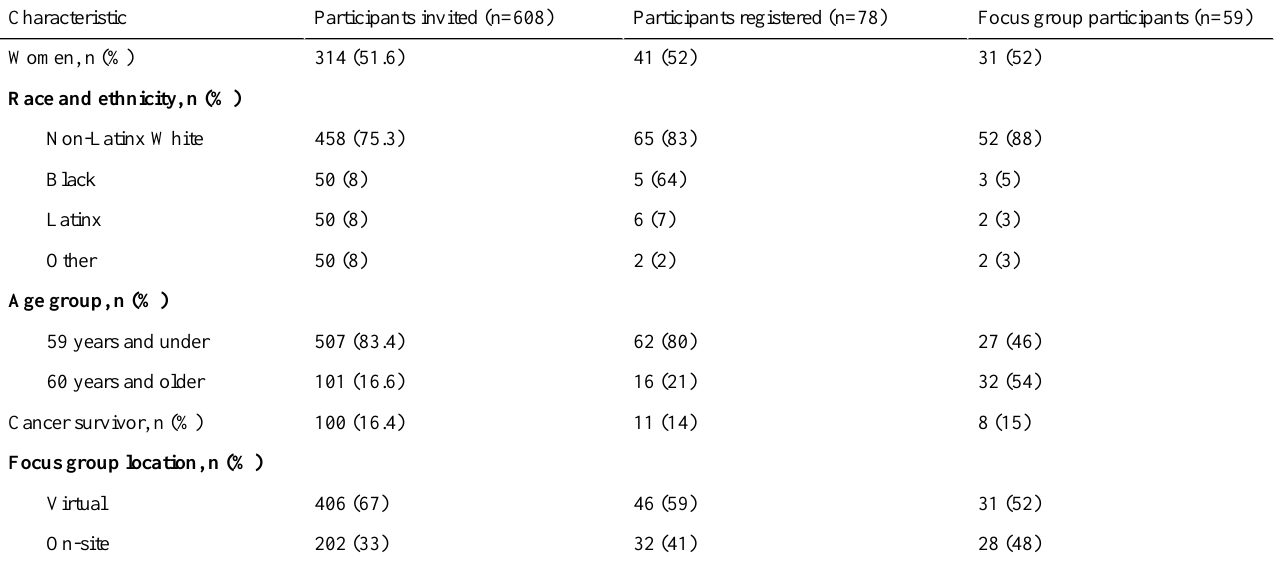
Table 1. Individual-level demographics (n=608 invited, n=59